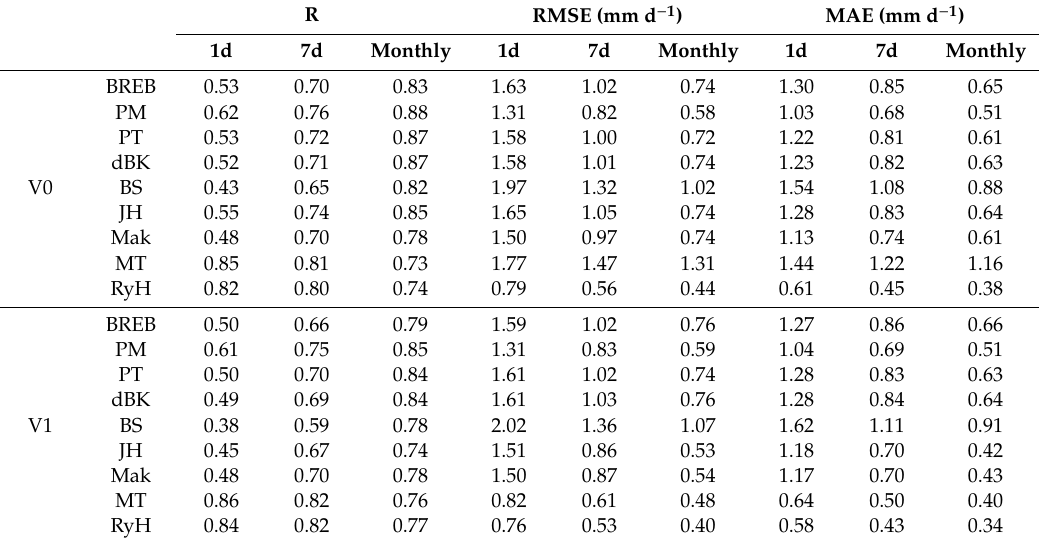
Table 2. Linear correlation (R), root mean square error (RMSE) and mean absolute error (MAE) between the estimated evaporation and the measured evaporation, under timescales of daily (1d), weekly (7d), and monthly. V0 and V1 represent the default and modified conditions, respectively.